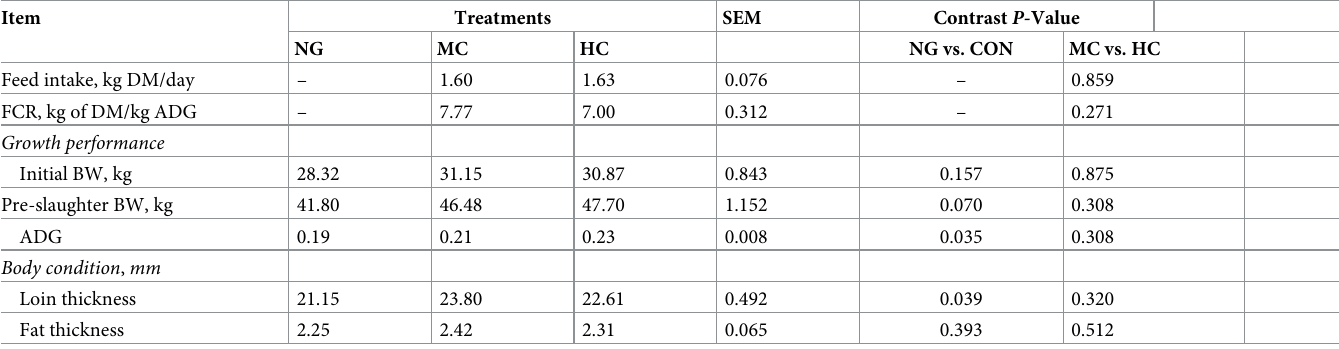
Table 2. Intake, growth performance, and body condition of lambs from different production